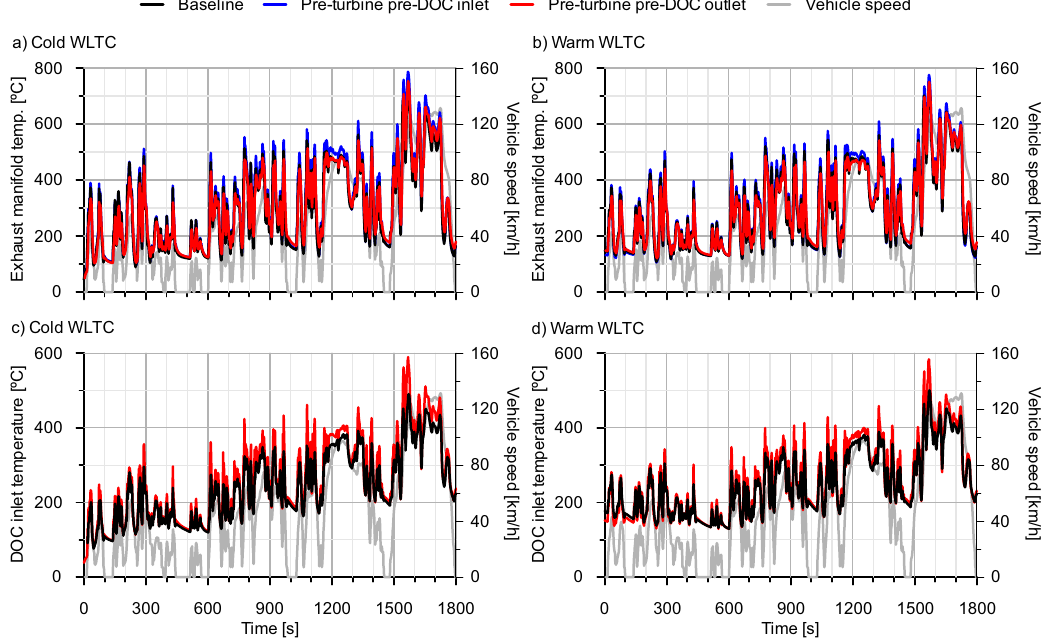
Figure 7. Pre-DOC, turbine and DOC inlet temperature in cold and warm WLTCs with baseline ATS and pre-turbine pre-DOC configurations. ( a ) Exhaust manifold temperature in cold WLTC, ( b ) exhaust manifold temperature in warm WLTC, ( c ) DOC inlet temperature in cold WLTC, ( d ) DOC inlet temperature in warm